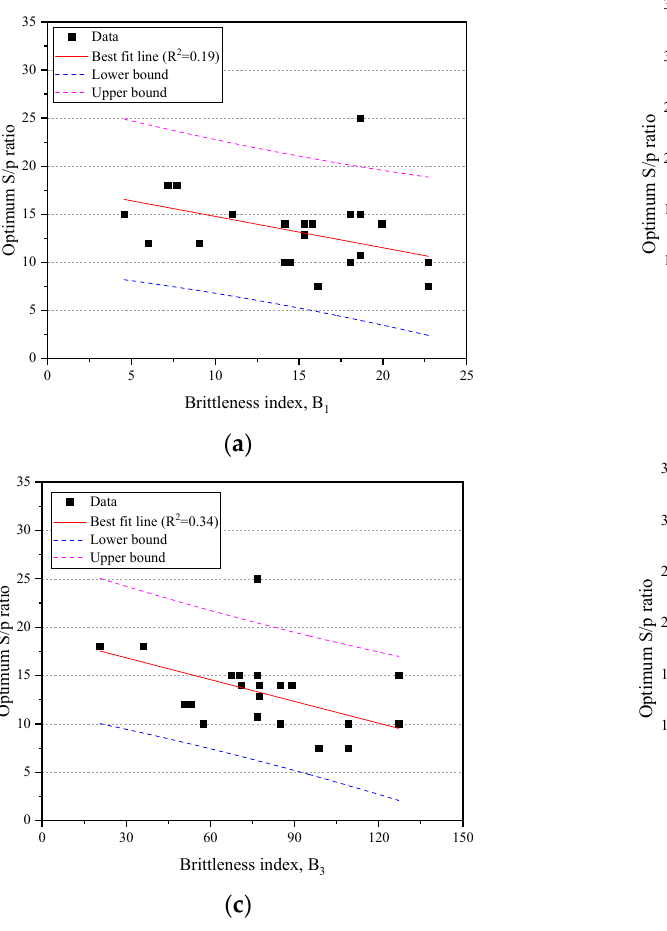
Figure 10. The relationships between optimum s/p ratio and brittleness indices: ( a ) S/p(opt)–B 1 ; ( b ) S/p(opt)–B 2 ; ( c ) S/p(opt)–B 3 ; ( d ) S/p(opt)–B 4 .